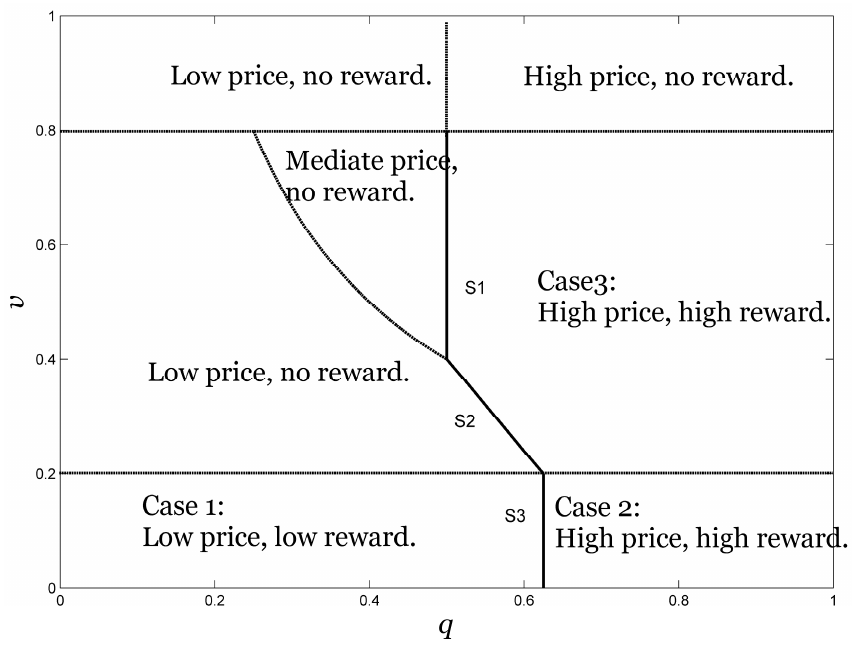
Figure 2. Optimal strategies for the firm ( (cid:1834) (cid:3404) 0.8 , (cid:1838) (cid:3404) 0.2 and β (cid:3404) 0.5 ).